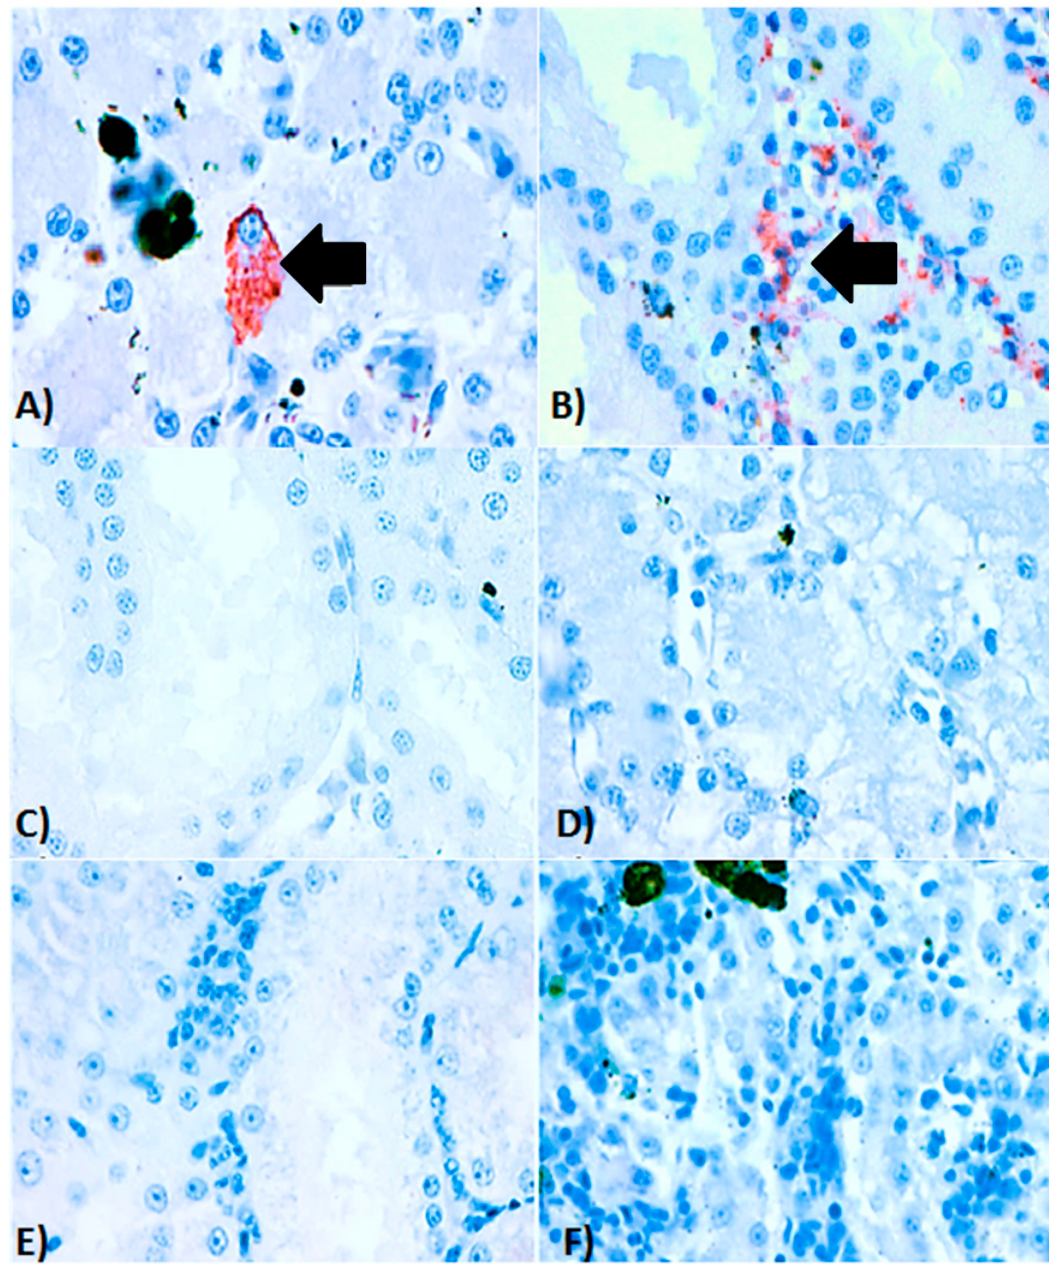
Figure 4. Immunohistochemistry of ranavirus-infected American bullfrogs ( Lithobates catesbeianus ). ( A ) Immunohistochemical staining of kidney, in which positive immunolabelling (red staining) is present in the renal cortical interstitium along with areas of necrosis and scant inflammation. ( B ) Immunohistochemical staining of a liver from an affected bullfrog with a focal area of positive immunolabelling (red staining) in the cytoplasm of a Kupffer cell. ( C ) Serial section of the kidney from the same animal without secondary antibody (control), ( D ) Serial section of liver from the same animal without secondary antibody (control). ( E ) Histological kidney section from an anuran which was PCR negative for ranavirus infection (control). ( F ) Histological liver section from an anuran which was PCR negative for ranavirus infection (control). Magnification for all photos 40×/50 µm.